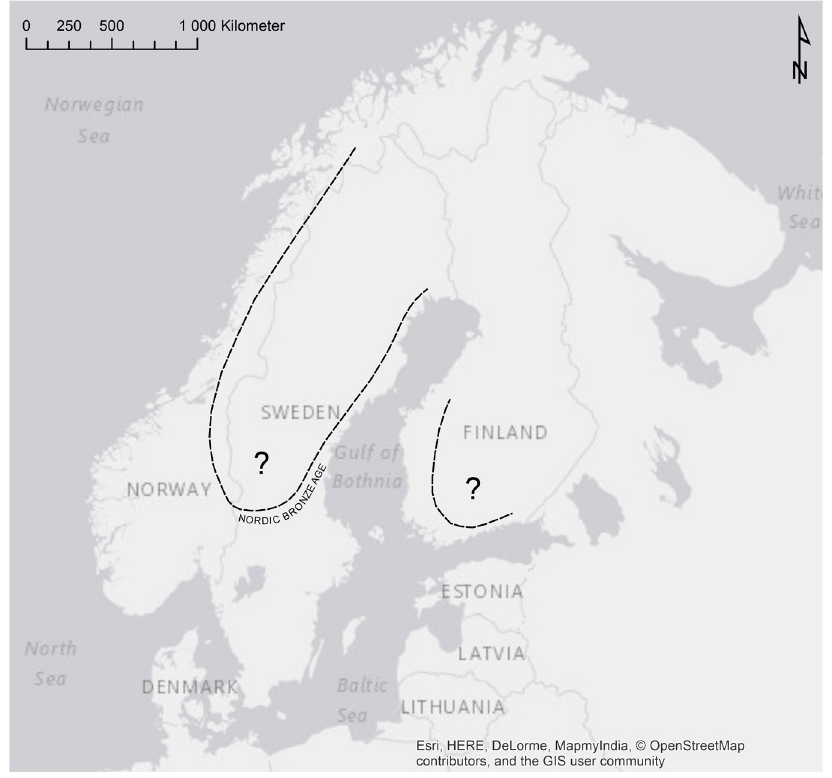
Figure 1: Map showing the approximate northern border of the Nordic Bronze Age sphere, as it has traditionally been concep- tualized in archaeological research. We argue that it is important to critically examine the construction of regions and borders in the Bronze Age in middle and northern Sweden. From Skandfer & Wehlin (2017, p.